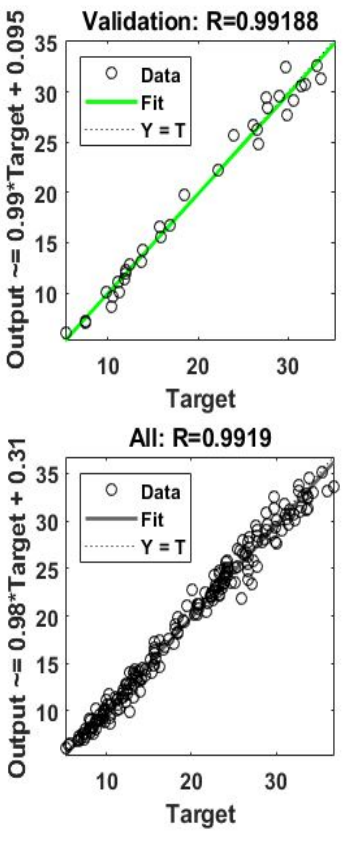
Figure 6. Regression Analysis of ANN. Regression represents the relationship between dependent variable, i.e., mass flow rate and independent variables, i.e., pressure, riser dp, total valve opening and single mean diameter of solid particles. In regression analysis we find a line that most closely fit the data according to the mathematical Equation (9). The regression line describes the strength of independent variables and the trend of dependent variable in future. The re- gression analysis is widely used in predicting, forecasting and error reduction applica- tions. The regression analysis for training, testing and validation is represented in blue, red and green line, respectively, as shown in Figure 6. 2.4. Adaptive Neuro Fuzzy Inference System (ANFIS) The precise prediction of solid circulation rate is carried out by ANFIS modeling approach which usually works at high pressure in circulating fluidized bed gasifier to improve the accuracy regarding syngas and input feedstock to the boiler. The architec- ture of ANFIS comprises of five layers of neuron as shown in Figure 7. Five membership functions were designed in fuzzification layer for fuzzifying all the crisp inputs in Equa- tion (3) (see Appendix A for details). If ‘m’ is number membership functions and ‘n’ is number of inputs then,